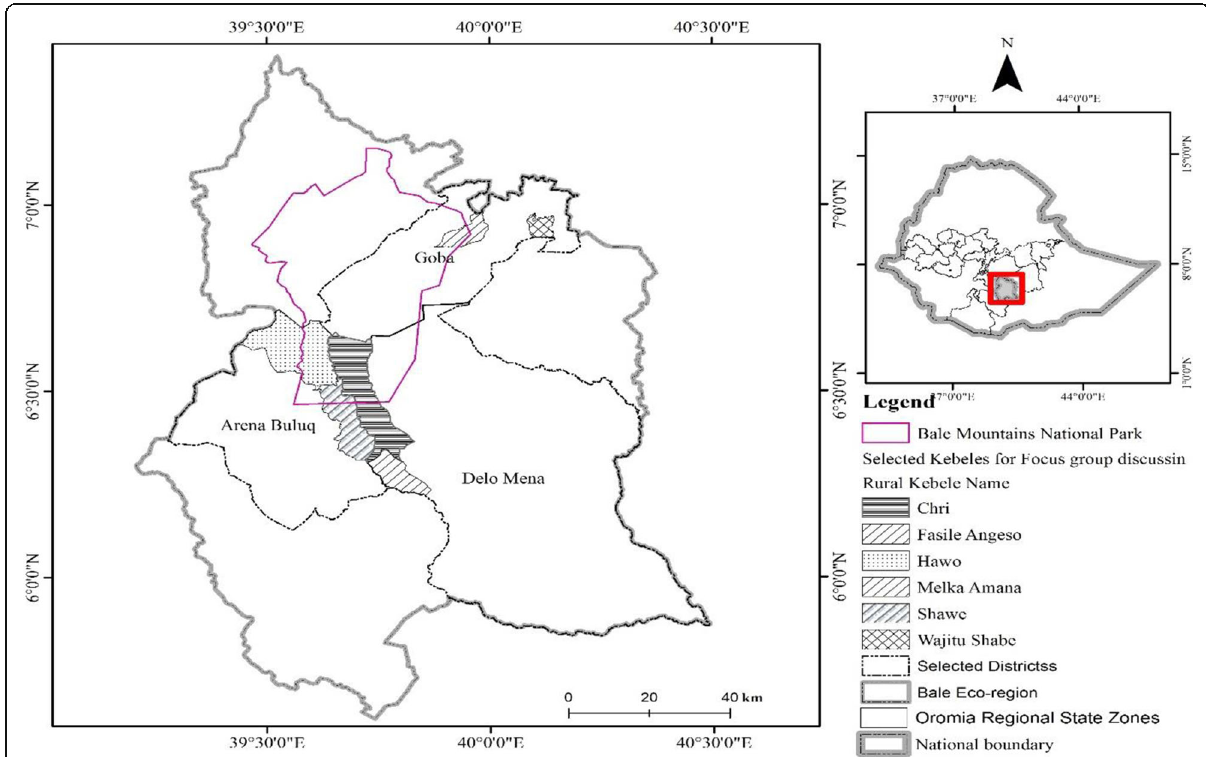
Fig. 1 Location map of BER and administrative boundaries (Woreda and sample